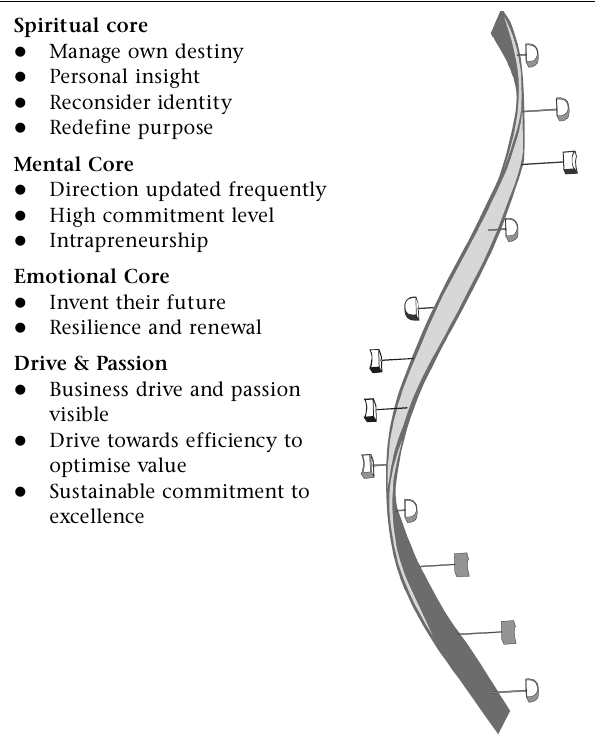
Figure 5: The Internal Orientation